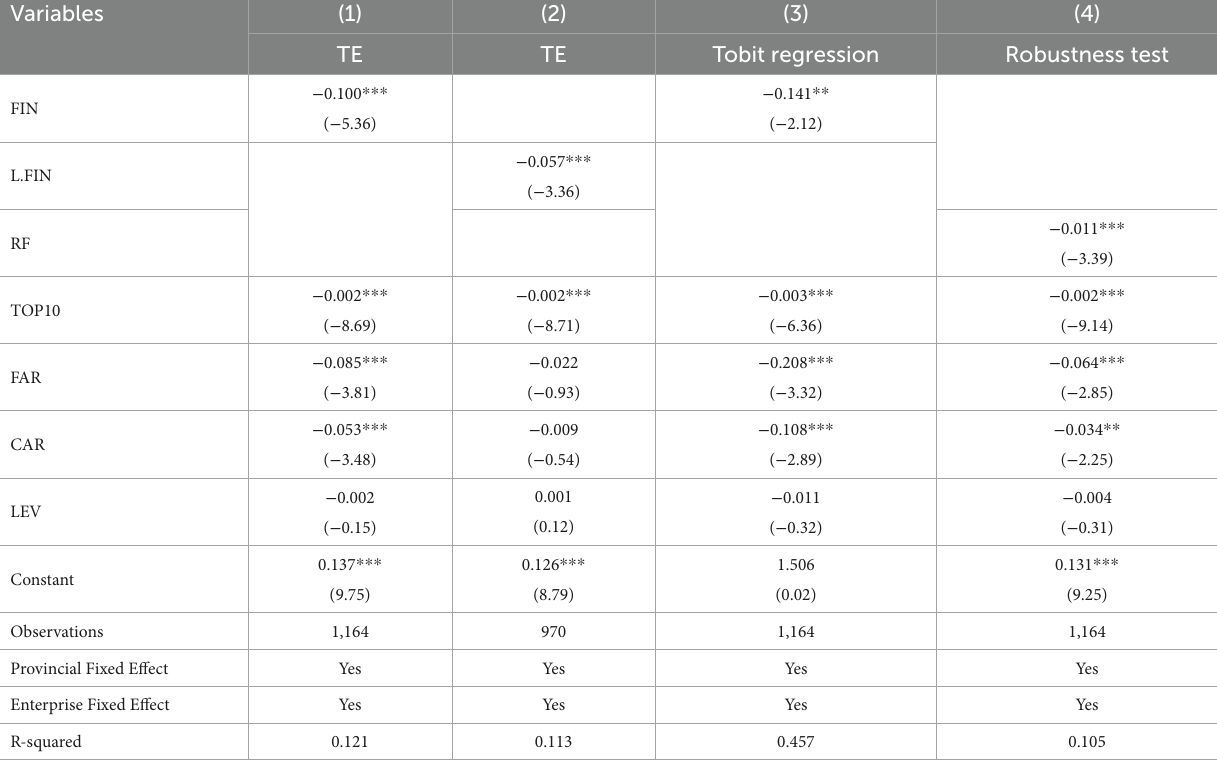
TABLE 4 Benchmark regression results and robustness